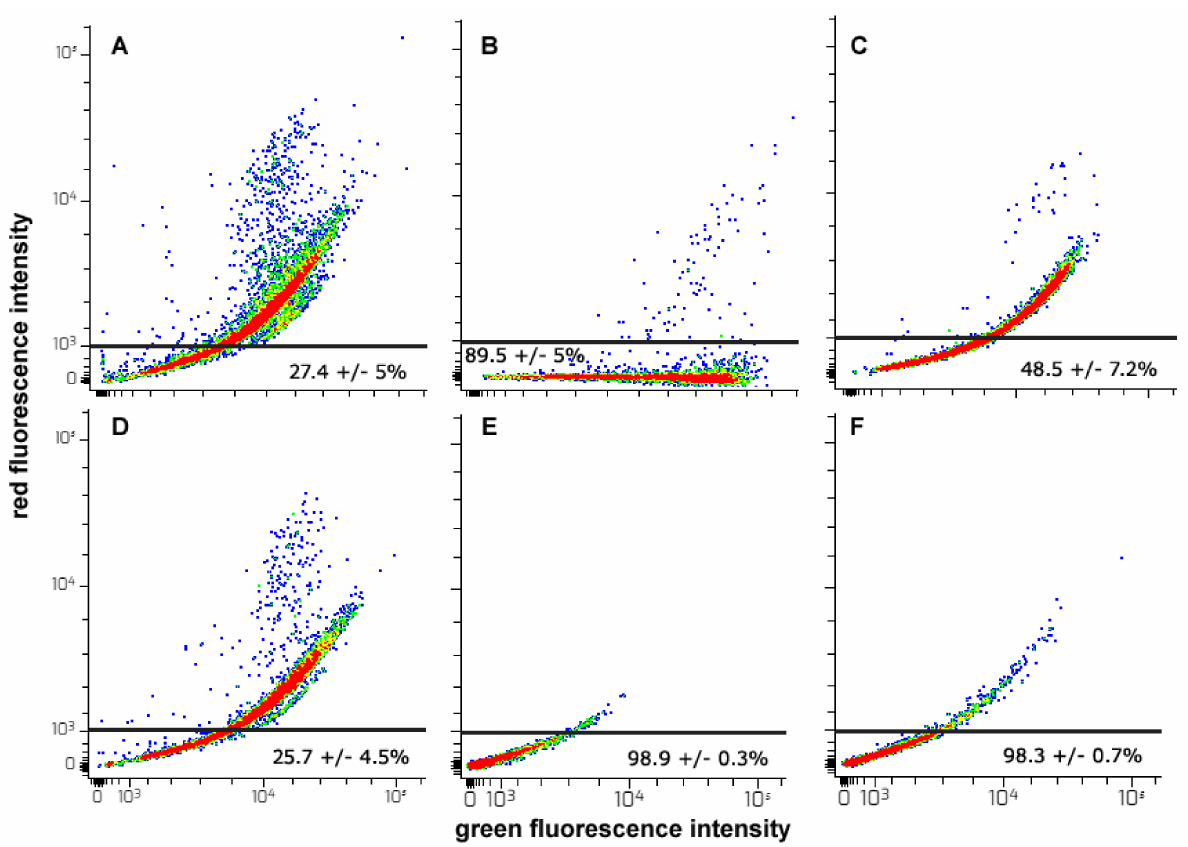
Figure 5. Flow cytometric assays for MMP in HepG2 cells cultured for 24 ( A – C ) or 48 h ( D – F ) under control conditions ( A , D ), in the presence of 1 µ M valinomycin ( B , E ) and of either CFE IC 50 24 ( C ) or CFE IC 50 48 ( F ). The plots display the outputs of representative experiments, and the percentages in the bottom quadrants of each frame expressed as the mean ± s.e.m. of triplicate experiments are related to dim red-emitting cells that underwent collapse of MMP.